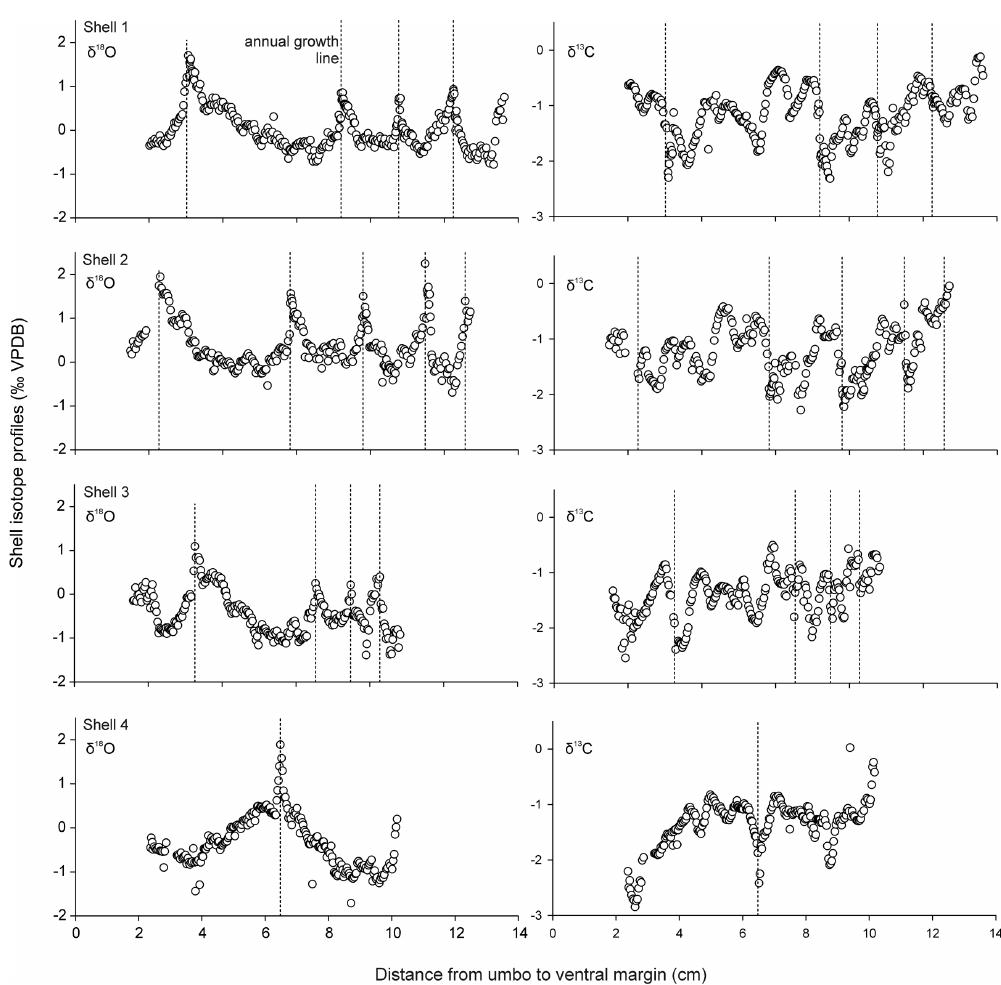
Fig. 2. Stable oxygen ( δ 18 O, left panel) and carbon ( δ 13 C, right panel) isotope profiles along the valve of four E. directus shells. Vertical dotted lines represent annual growth lines observed on the surface of the shell and in the acetate